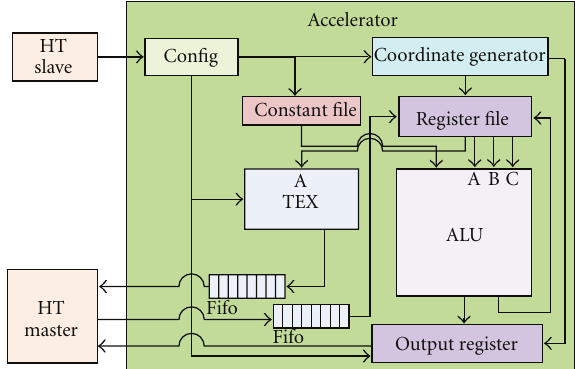
Figure 4: Overview of a GPU-like accelerator, connected to a Hypertransport (HT) master and